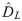
Primary school data set: Normalized temporal differences for the three spectral distances: Combinatorial Laplacian D^L, normalized Laplacian D^L, and adjacency D^A.